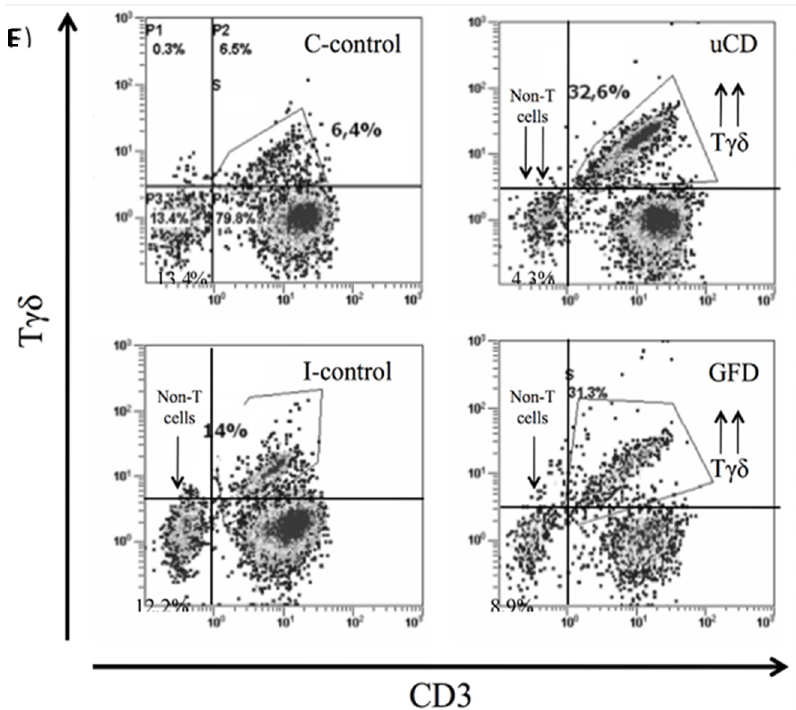
Figure 5. Phenotype of intraepithelial lymphocytes in the duodenum from celiac patients. Phenotype of IELs in untreated Celiac Disease (uCD), Gluten Free Diet ‐ CD patients (GFD ‐ CD), inflamed non ‐ CD controls (I ‐ controls) and non ‐ inflamed non ‐ CD controls (C ‐ controls), analyzed by flow cytometry: Percentage of total IELs (CD103 + CD45 + ) referred to the total of epithelial cells (A). Percentage of non ‐ T cells (CD103 + CD45 + CD3 − ) (B), T γδ cells (CD103 + CD45 + CD3 + TCR γδ + ) (C) and T αβ cells (CD103 + CD45 + CD3 + TCR γδ − ) (D) referred to the total of IELs. Horizontal bar are median values. Statistically significant differences are shown (two tailed Mann Whitney U test; p < 0.05). Representative flow cytometry analysis data of IEL subpopulations (T γδ , T αβ and non ‐ T cells) in uCD, GFD ‐ CD, I ‐ controls and C ‐ controls (E). Table 3. Specificity of intraepithelial lymphocytes profiling in the diagnosis of celiac disease. uCD GFD ‐ CD I ‐ controls C ‐ controls Median Median Median Median (IQR) (IQR) (IQR) (IQR) Total IELs 16.80% (4.80) 10.40% (4.11) 10.70% (3.70) 8.50% (2.60) Non ‐ T cells 3.10% (4.00) TCR αβ + cells 59.30% (15,6) 62.10% (14,5) Percentages of duodenal Intraepithelial lymphocyte (IEL) populations in untreated Celiac Disease